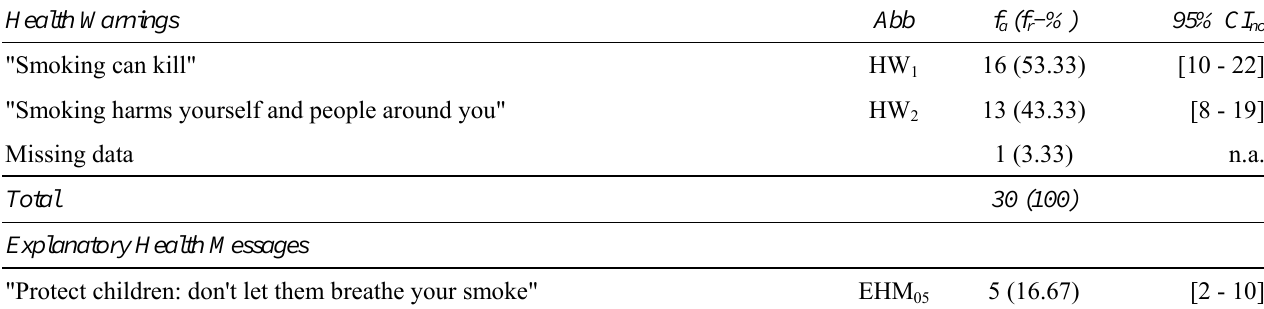
Table 7: Public health information: health warnings and explanatory health messages Health